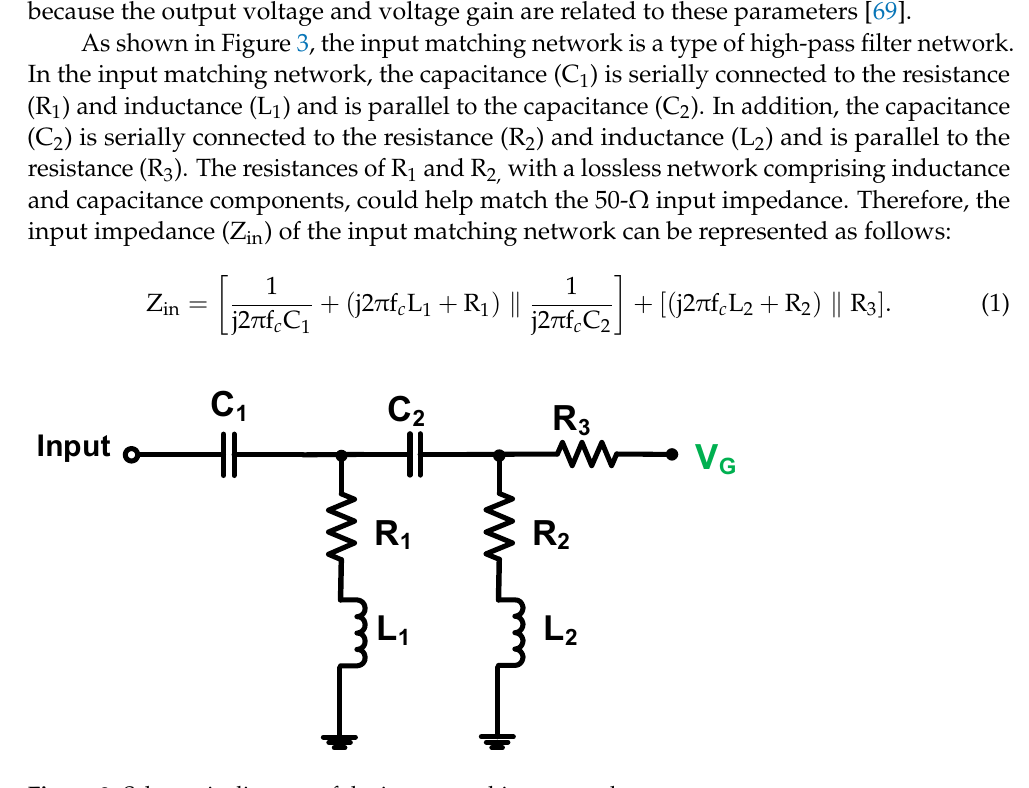
Figure 3. Schematic diagram of the input matching